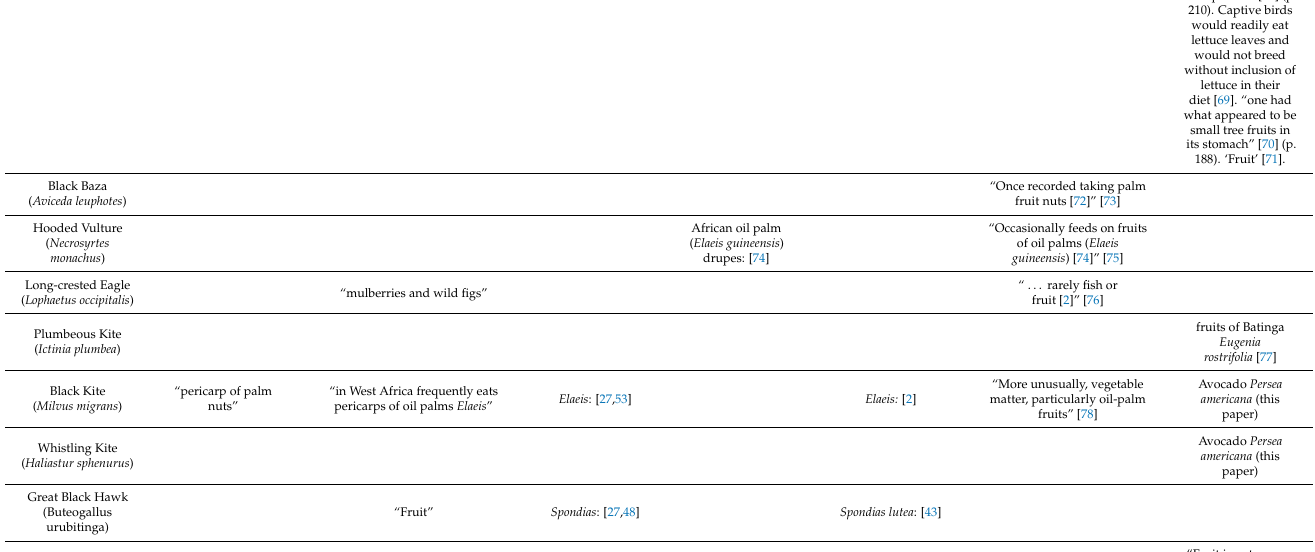
Figsandother fruits:[2]